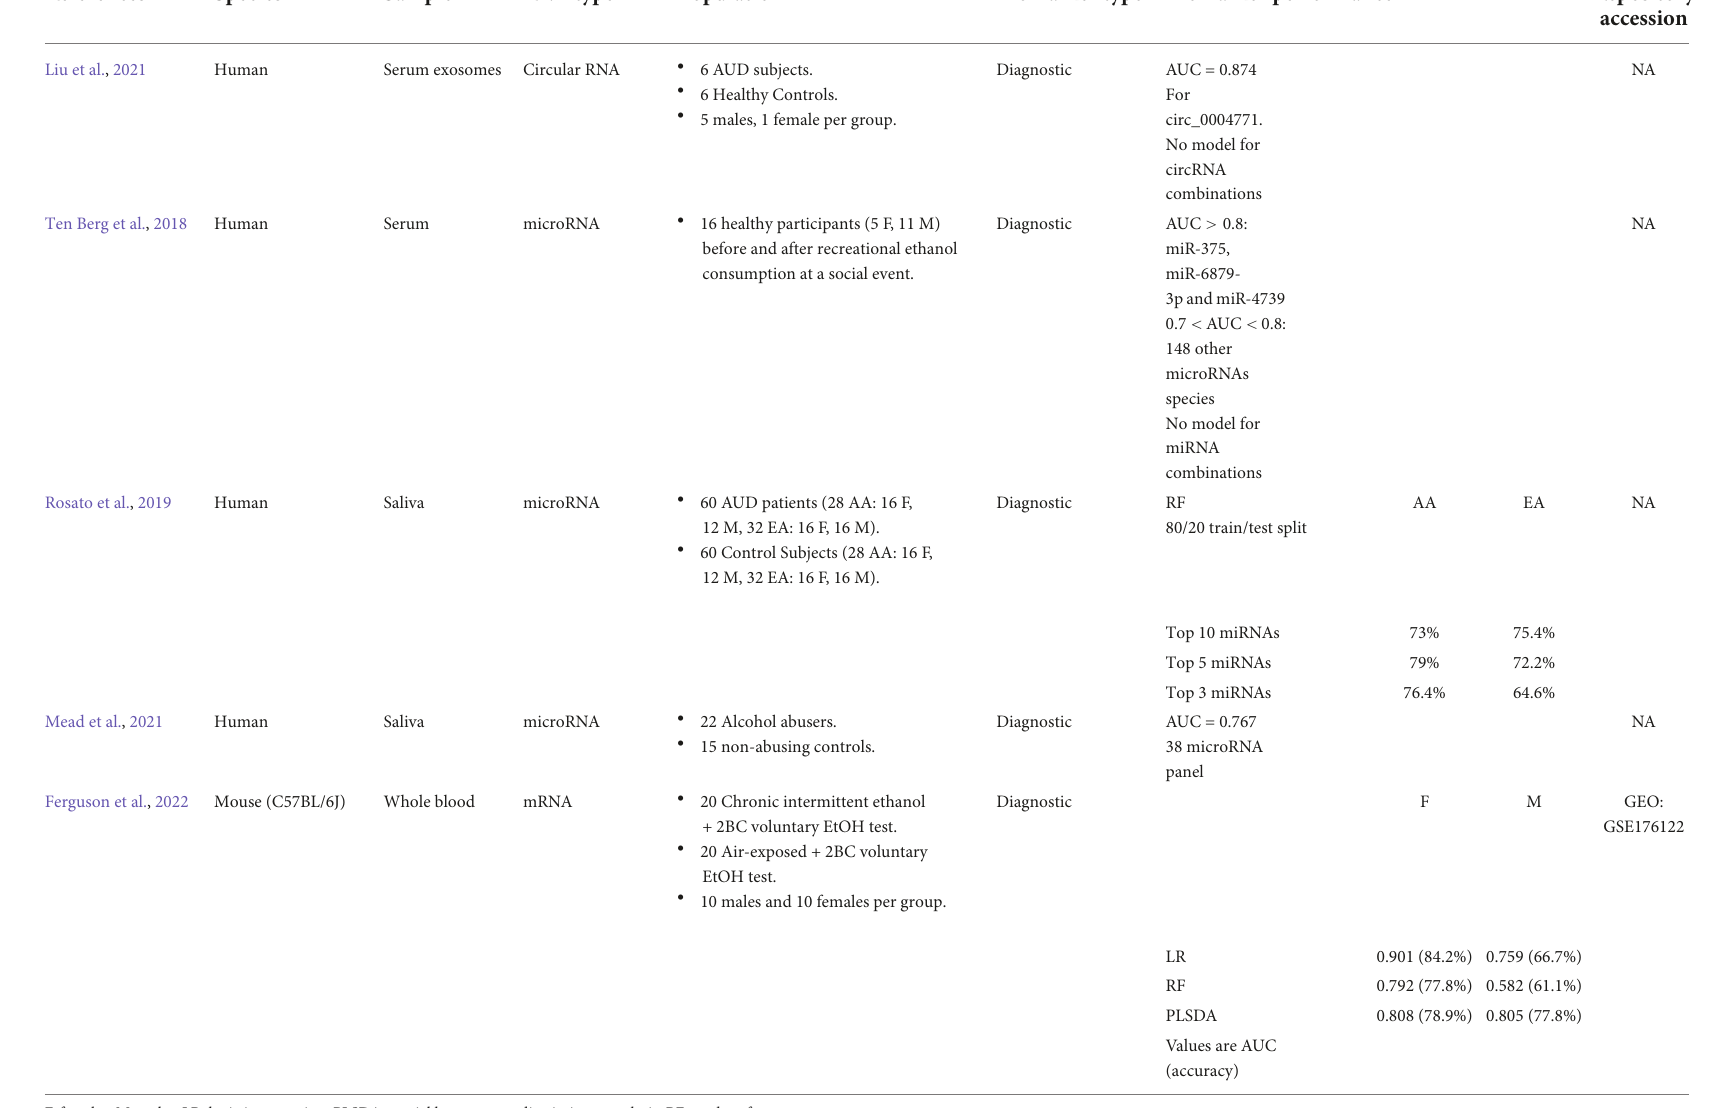
TABLE 2 Alcohol transcriptome biomarker